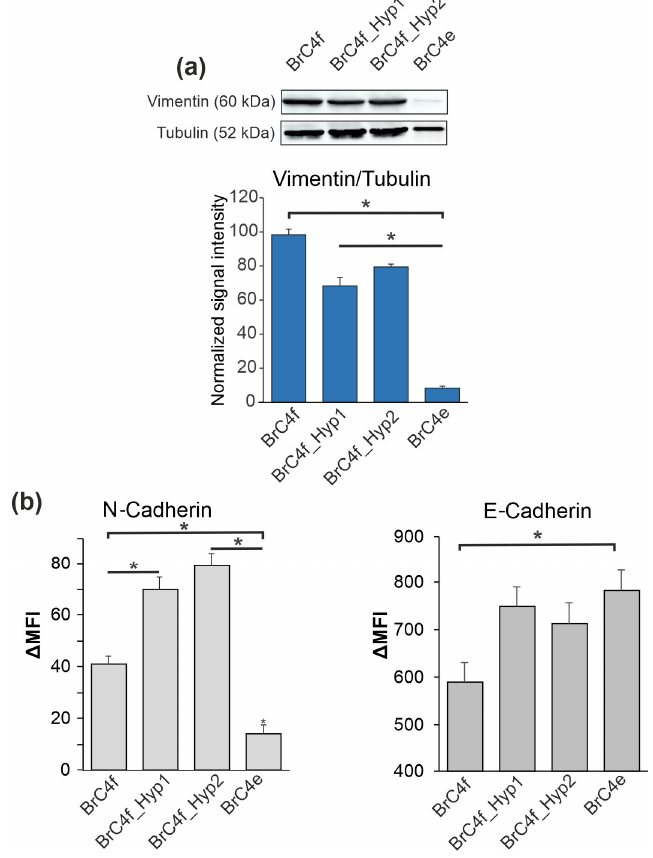
Figure 2. Changes in epithelial and mesenchymal molecular markers in cell cultures after rounds of hypoxia. BrC4f, BrC4f_Hyp1, BrC4f_Hyp2 and BrC4e cells were analyzed. ( a ) Western blot analysis of vimentin in cell lysates; tubulin was used as loading control. ( b ) Flow cytometry analysis of the surface-located N-cad and E-cad. Data are presented as Mean Fluorescence Intensity (MFI) ± SD. The differences were significant with * p < 0.05 between two groups.